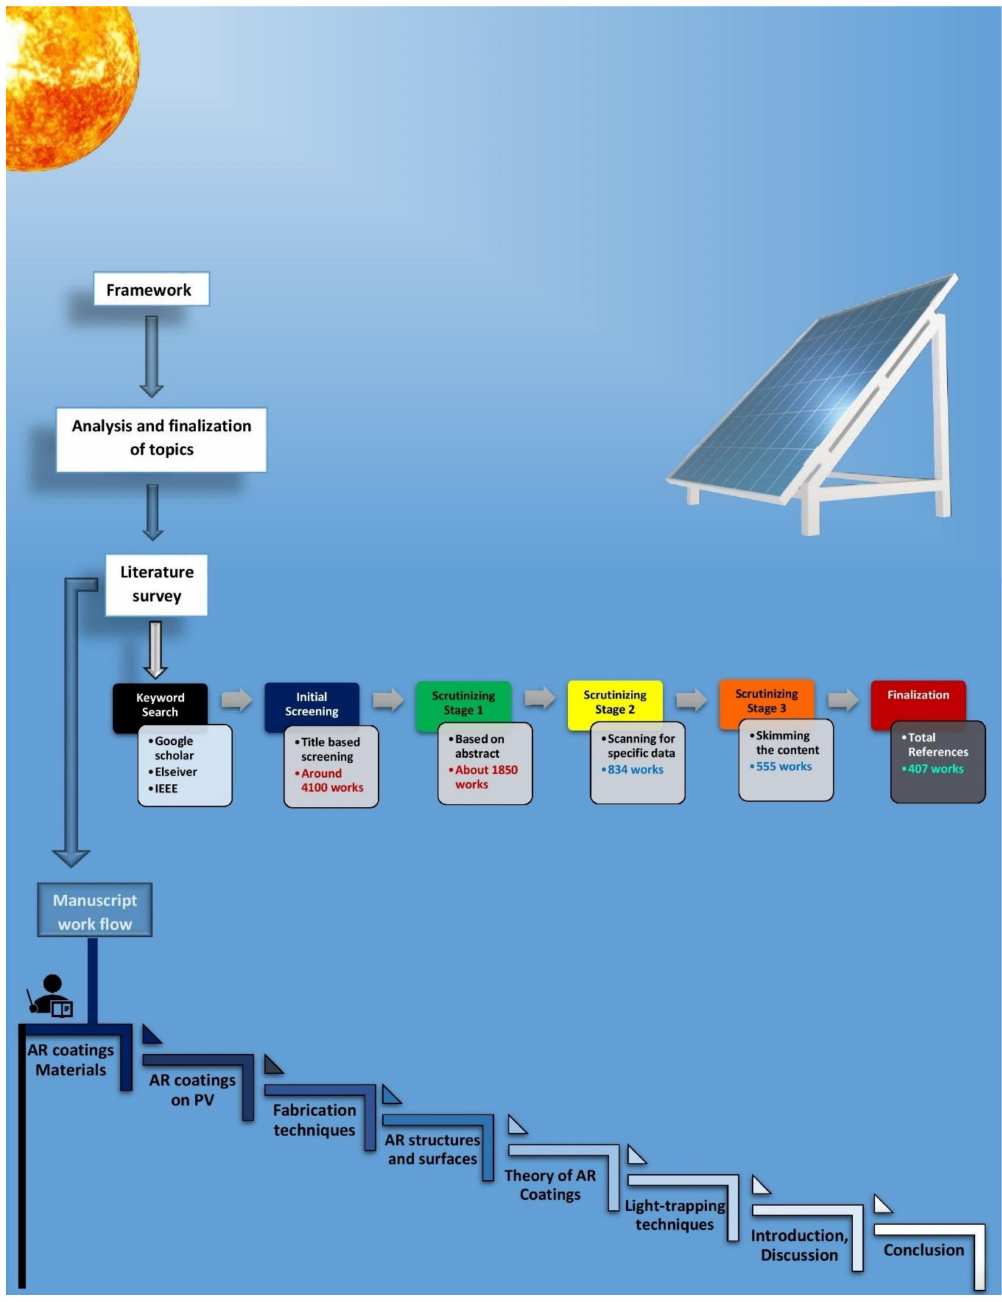
Figure 1. The framework of the